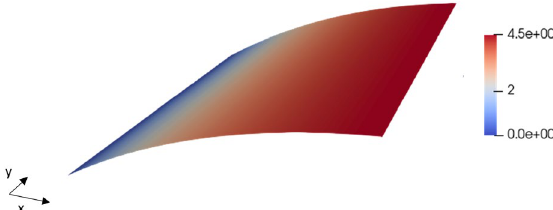
Fig. 9 Elevation of the numerical